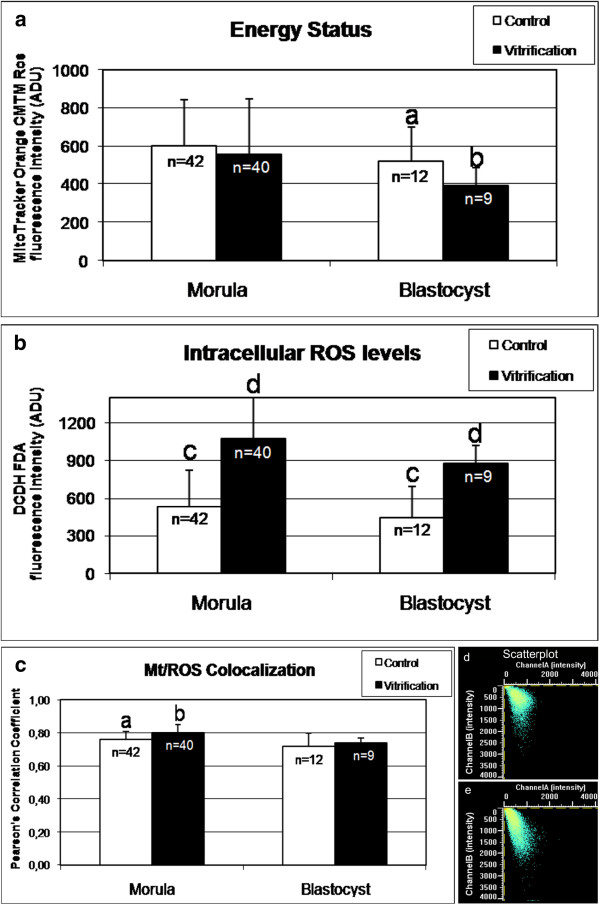
Effects of vitrification on mitochondrial activity, intracellular ROS levels and mt/ROS colocalization in single mouse morulae and blastocysts. In each group, energy status and ROS intracellular levels are expressed as mean±SD of Mitotracker Orange CMTM Ros (panel a) and DCF (panel b) fluorescence intensity of individual embryos in arbitrary densitometric units (ADU). In each group, mt/ROS colocalization is expressed as mean±SD of Pearson’s correlation coefficient of individual embryos (panel c). Representative mt/ROS colocalization scatterplots graph of a fresh (panel d) and a vitrified (panel e) blastocyst are shown. In embryos at the morula stage, mt activity did not change after vitrification whereas in embryos at the blastocyst stage, mt activity was significantly reduced (P<0.05). ROS levels significantly increased in vitrified embryos at morulaand blastocyst stages (P<0.001). Mt/ROS colocalizationsignificantly increased in vitrifiedmorulae. Numbers of analyzed embryos per group are indicated on the top of each histogram. Student’s t-Test: a,b P<0.05; c,d P<0.001.